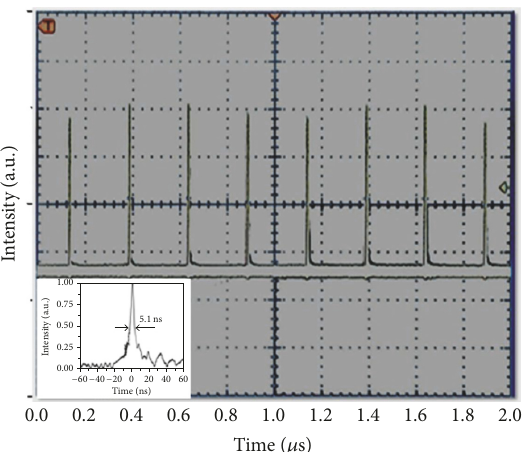
Figure 4: Pulse train with a repetition rate of 200 kHz in the LGS electrooptic Q-switched Nd:LuVO 4 laser. Inset: pulse profile with the shortest pulse width of 5.1ns. Reprinted with permission from [18]. Copyright 2016 Springer Nature Group.